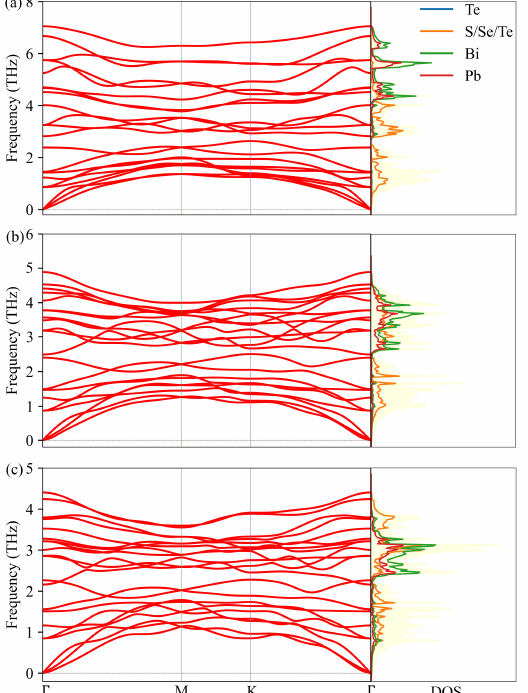
Figure 4. Phonon spectrum curves of PbBi 2 Te 2 S 2 ( a ), PbBi 2 Te 2 Se 2 ( b ), PbBi 2 Te 4 ( c ) and corresponding total DOS (light yellow background) and projected DOS (color